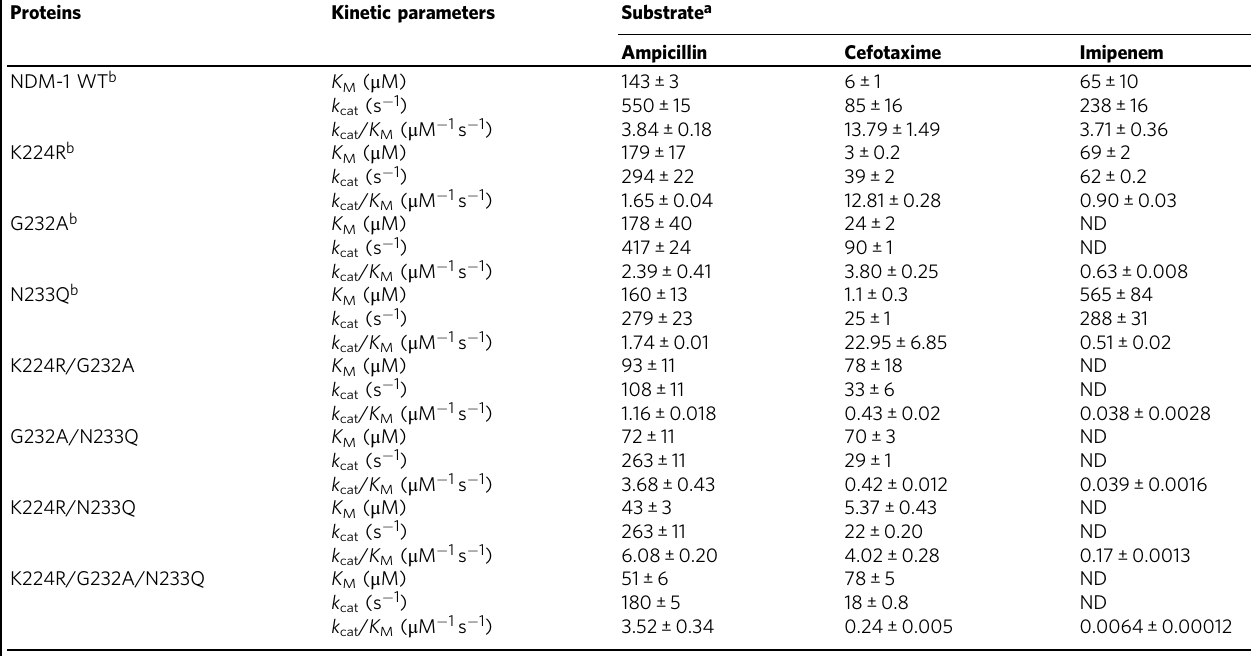
Table. 3 Enzyme kinetic parameters for NDM-1 single and combinatorial mutants